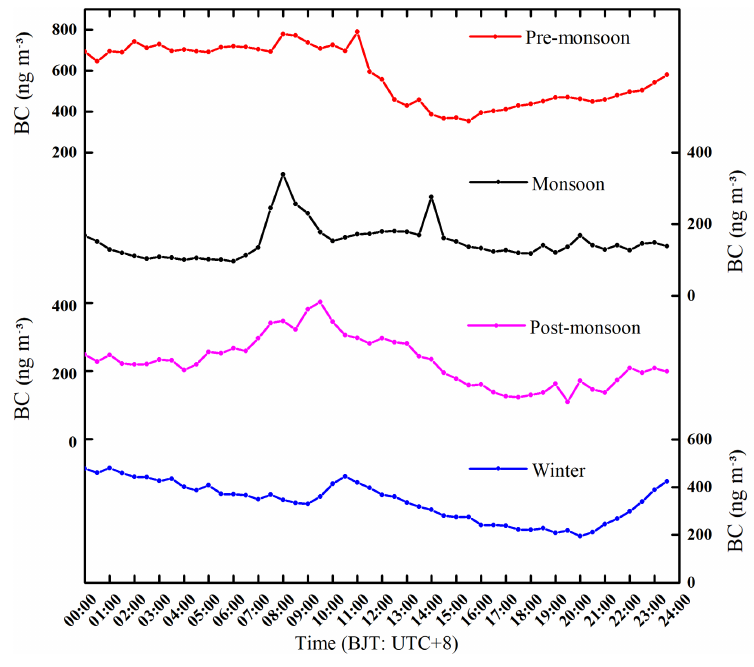
Figure 4. Diurnal variation in BC concentrations (every half an hour) at QOMS during study period.